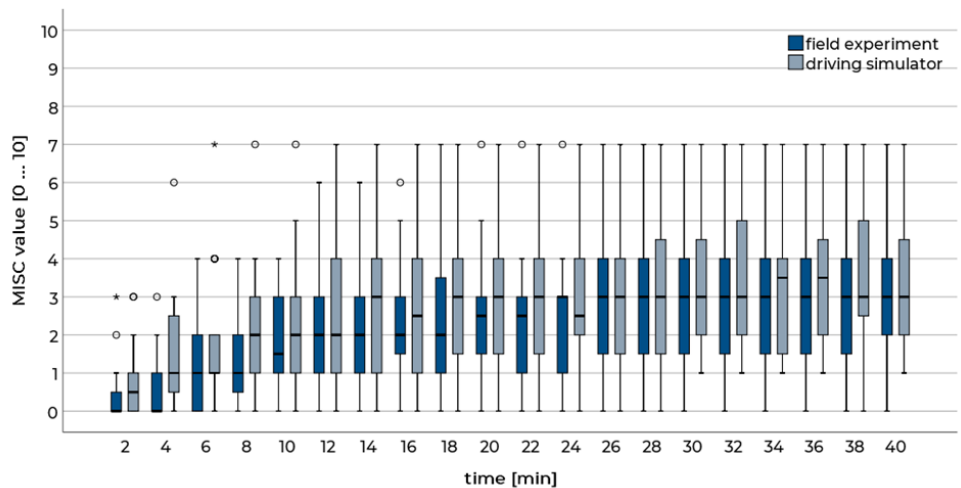
Figure 1. Misery scale (MISC) rating over time during the runs in a real vehicle and in the high-level driving simulator. Sessions were terminated when a value of 7 = moderate nausea was given. These participants were assigned continuing values of 7 for the purpose of this illustration. Boxplots are shown.